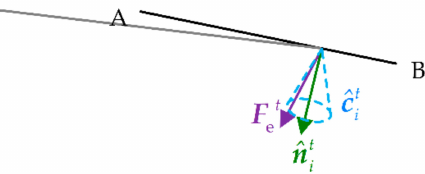
Figure 4. Probabilistic model based on force information. The solid black line indicates the uncertain operating object and the solid gray line indicates the end of the